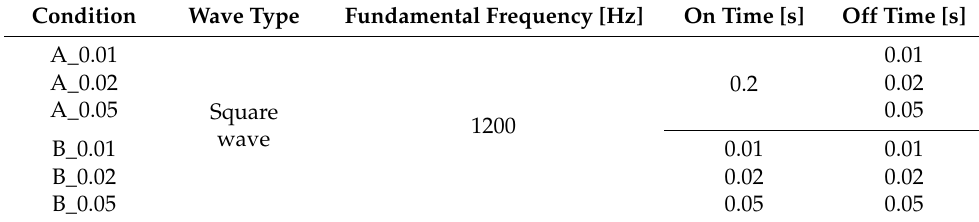
Table 7. List of warning sounds adopted for Phase 3 of the present study.